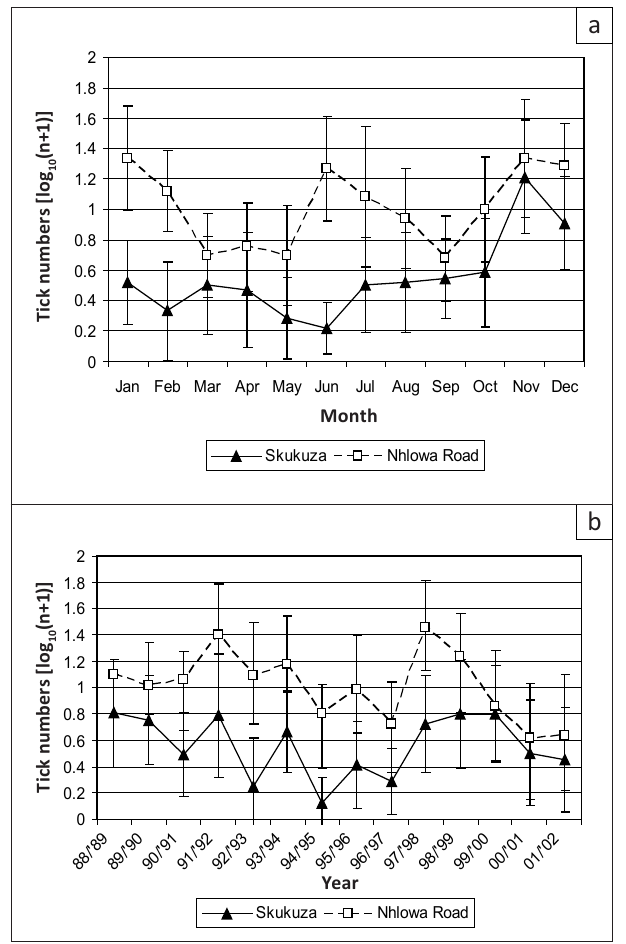
FIGURE 4: Mean collections (± 95% confidence interval) of Rhipicephalus evertsi evertsi larvae (a) by month and (b) by year at the two sites.